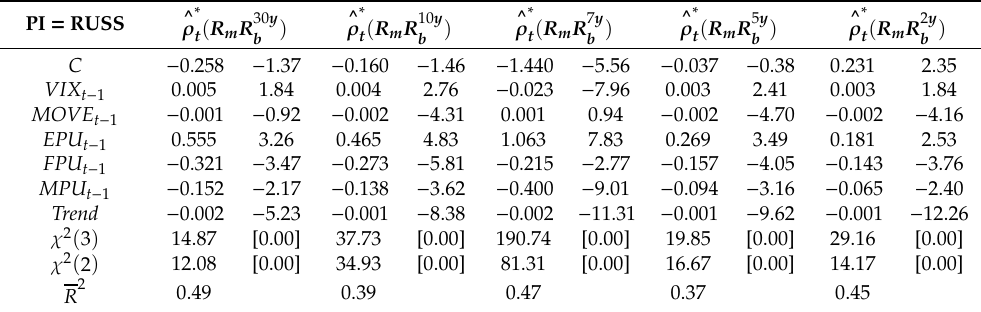
Table 7. Estimates of aggregate and categorical EPU, FPU, and MPU and on stock (RUSSELL)–bond return correlations.